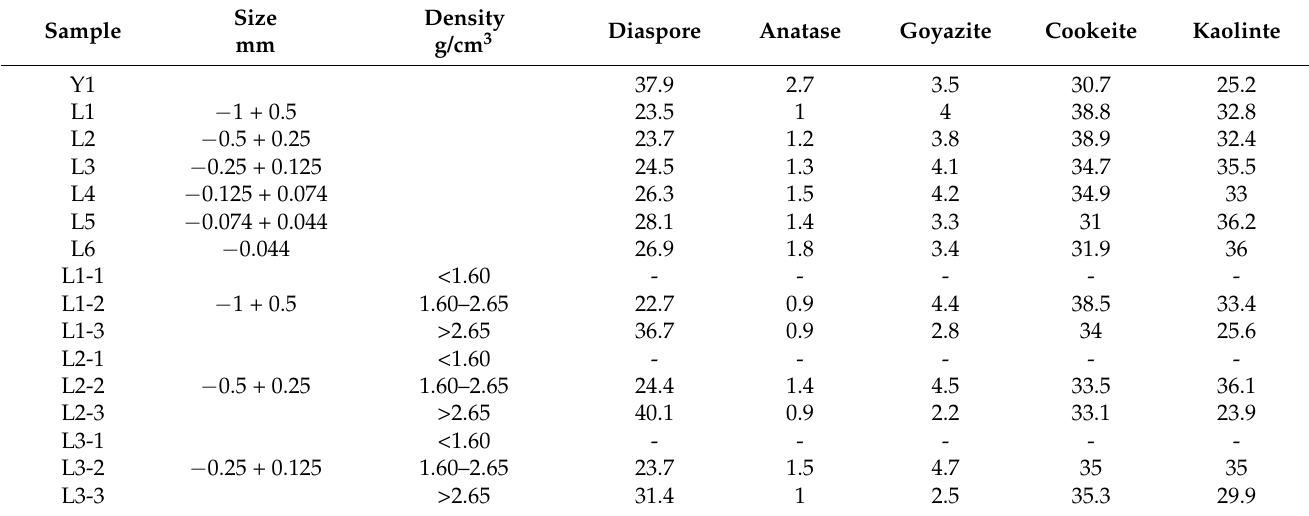
Table 1. For clay-mineral identification, oriented-aggregates of the <2 µ m clay fractions from the raw ore sample were evaluated by XRD according to SY/T5163-2018 [18]. Table 1. Quantitative mineralogical compositions (%) of sample Y1 and the samples subjected to size and density